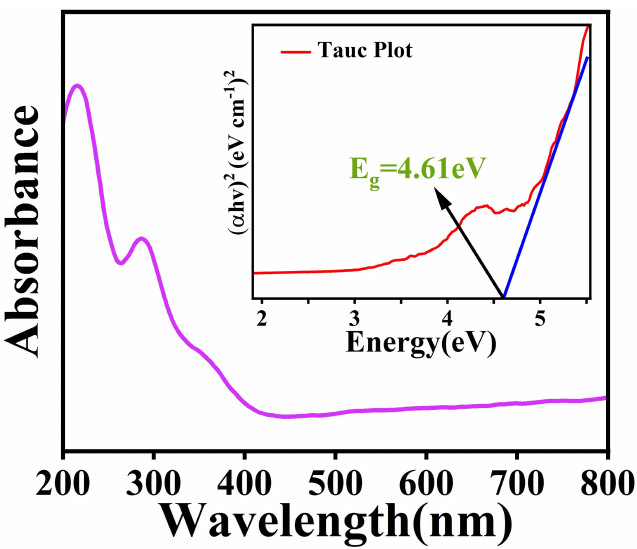
Figure 11. UV absorption diffuse reflection spectrum of the prepared SrAl 2 O 4 : Eu 2+ ,Dy 3+ (inset:the band gap